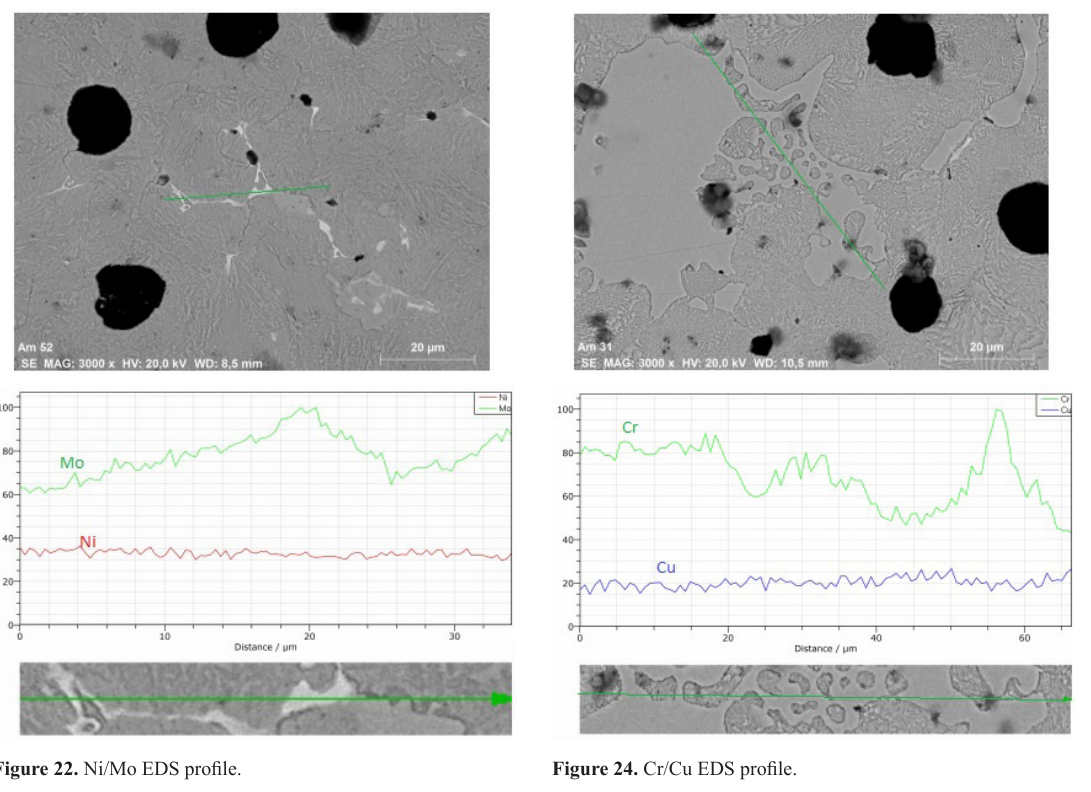
Figure 22. Ni/Mo EDS profile.